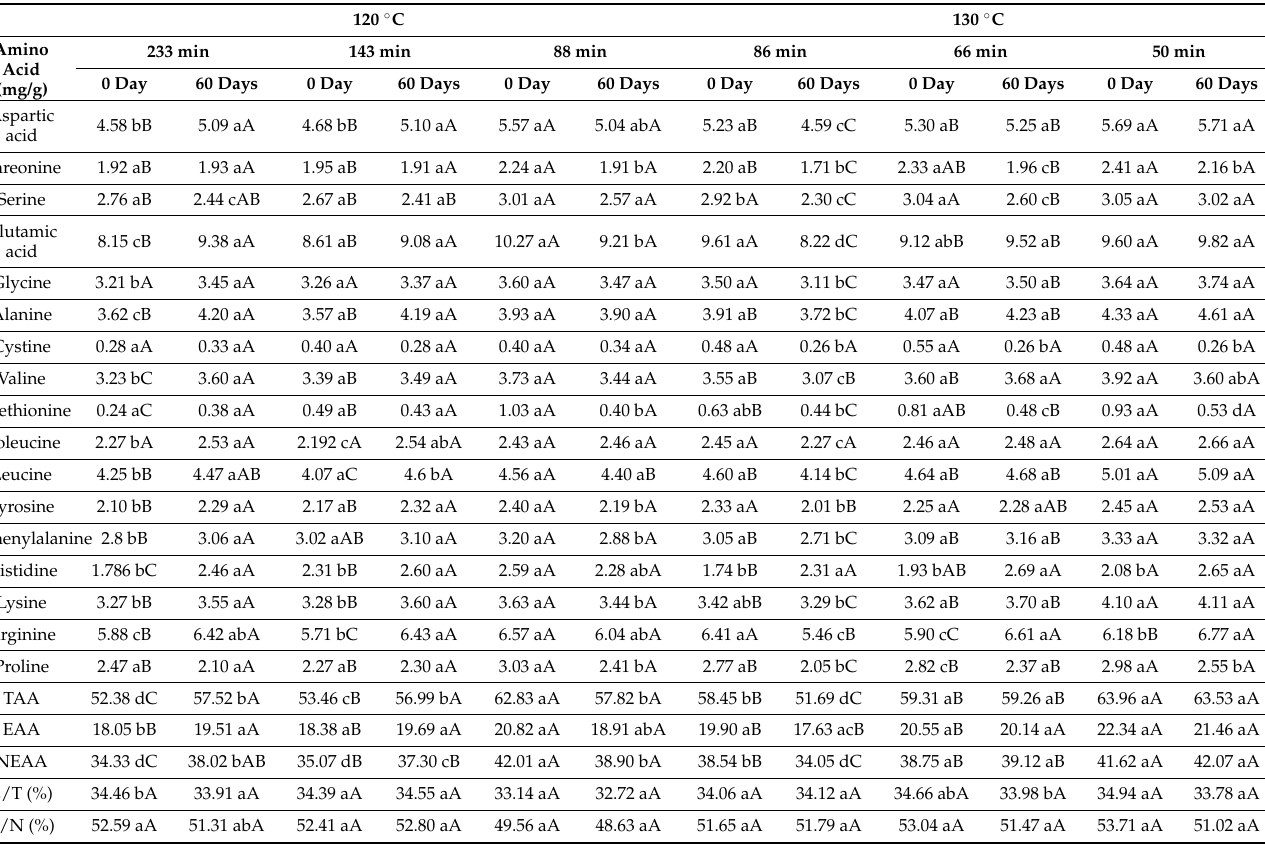
Table 3. Amino acid composition and content changes in dry-heat-treated rice bran at 120 and 130 ◦